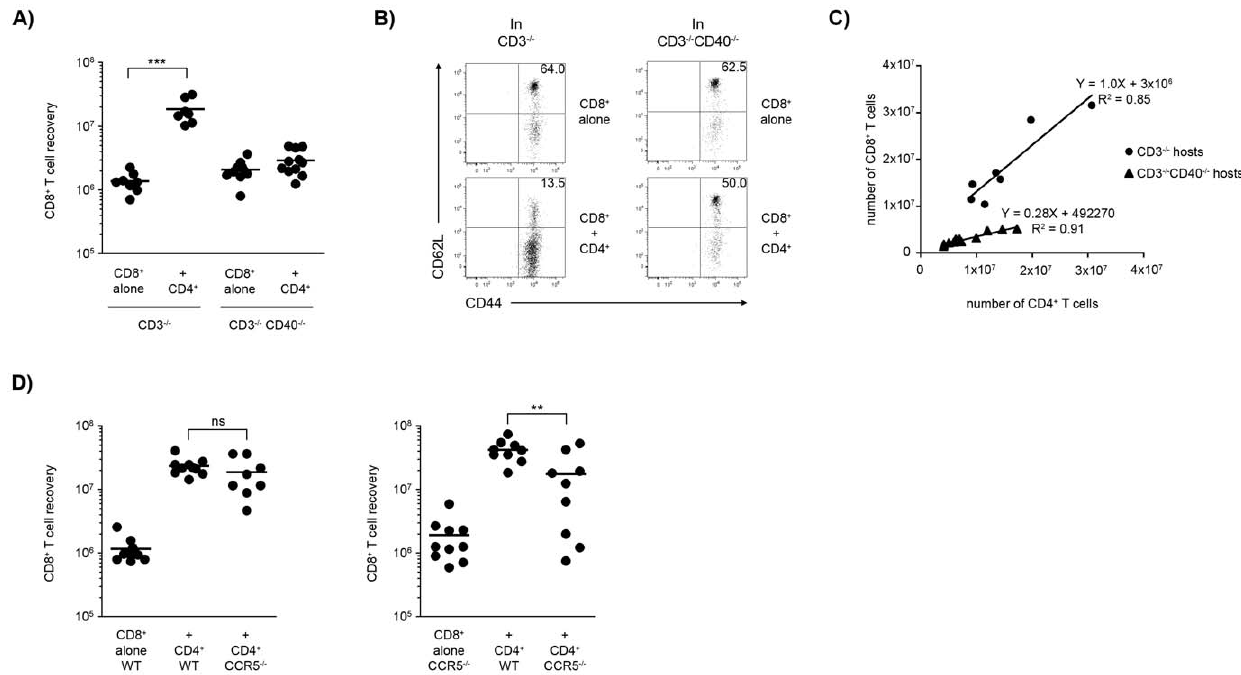
Figure 4. Role of CD40-CD40L interactions and CCR5. ( A ) 2 6 10 4 CD8 + T cells were transferred alone or co-transferred with 2 6 10 4 CD4 + T cells into either CD3 e 2 / 2 or CD40 2 / 2 CD3 e 2 / 2 mice. The CD8 + T cell recovery 8 weeks after transfer is shown from 2-pooled experiments (N=9). The helper effect observed in CD3 e 2 / 2 hosts was absent in CD40 2 / 2 CD3 e 2 / 2 hosts (*** p , 0.001). ( B ) Dot plots showing representative examples of the CD62L and CD44 expression by CD8 + T cells recovered in the different groups of mice. ( C ) Correlation of the number of CD8 + and CD4 + T cells recovered in individual WT and CD40-deficient hosts. The correlation coefficients are shown (p , 0.02 and p , 0.001 respectively). Note the different slopes between WT and CD40-deficient hosts. ( D ) 10 4 CD8 + T cells from WT (left) or CCR5 2 / 2 (right) were transferred alone or with CD4 T cells from WT or CCR5 2 / 2 into CD3 e 2 / 2 host. The absolute number of CD8 + T cells recovered in the six groups 7 weeks after transfer, pooled from 2 independent experiments. Note that a similar 20-fold enhanced expansion of the WT and CCR5 2 / 2 CD8 + T cells was detected in the presence of WT CD4 + T cells. When both CD8 + and CD4 + T cells lacked CCR5 from the nine mice studied only two mice showed accumulation of CD8 as that observed in the presence of WT CD4 + T cells, and three mice had a lack of CD4-help. The results indicate that to achieve an optimal helper effect the CCR5 receptor should be expressed by either the CD8 + or CD4 + T cells. Relevant statistically significant differences are shown (** p # 0.01).